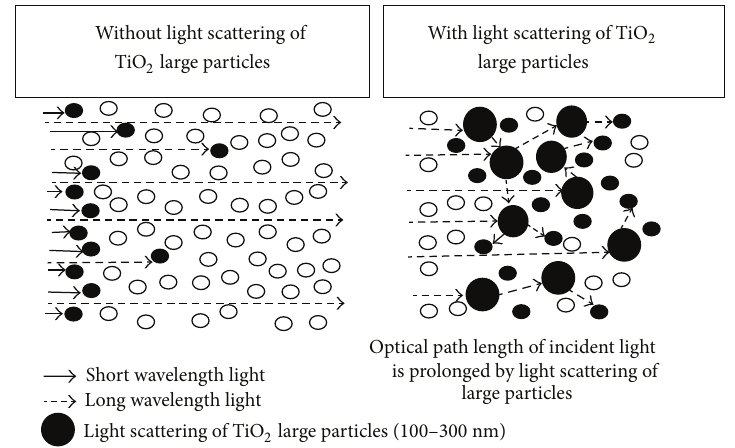
Figure 7: Light scattering concept depending on particle size of a material reproduced by Attaf